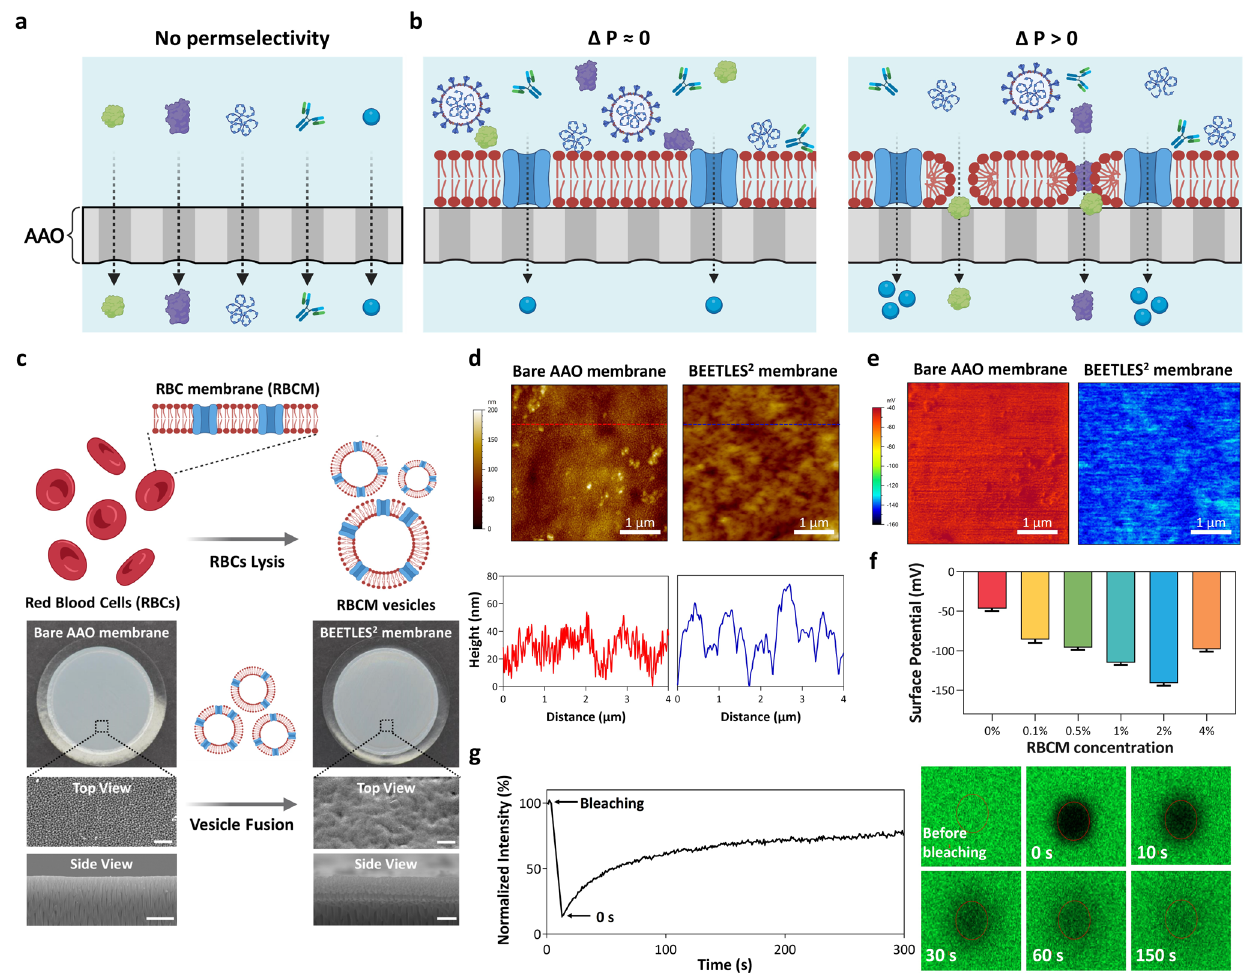
Fig. 2 | Physicochemical characterization of BEETLES 2 membrane. a AAO membrane with analigned 20nm pore asa substrate, showing no permselectivity. b Functionalization of RBCM onto the AAO membrane, showing permselectivity and tunability under applied pressure. c Fabrication and topological analysis of BEETLES 2 membrane. d AFM images showing topography and cross-sectional pro fi les from the height map images of bare AAO and BEETLES 2 membrane. ( e , f ) KPFManalysisof( e )surfacepotentialimagesofbareAAOandBEETLES 2 membrane and f Frequencies of surface potential depending on RBCM concentration (0-4% (v/v)). Data are from three pooled experiments (0% RBCM, n =30; 0.1-4%